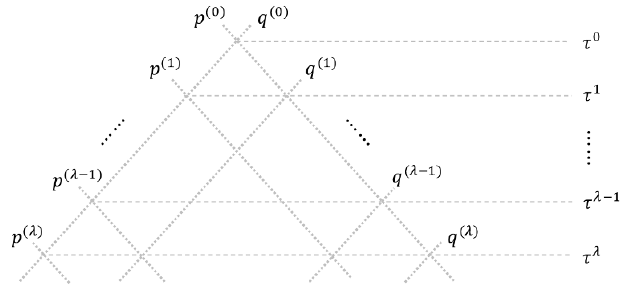
Figure 1. The Pascal triangle of single and double soft expansion. (cid:28) denotes the double soft order. is used. For example, using current algebra to reproduce theorems derived from CHY representation is bound to failure, as was the case for (cid:28) 2 and (cid:28) 3 double soft theorems